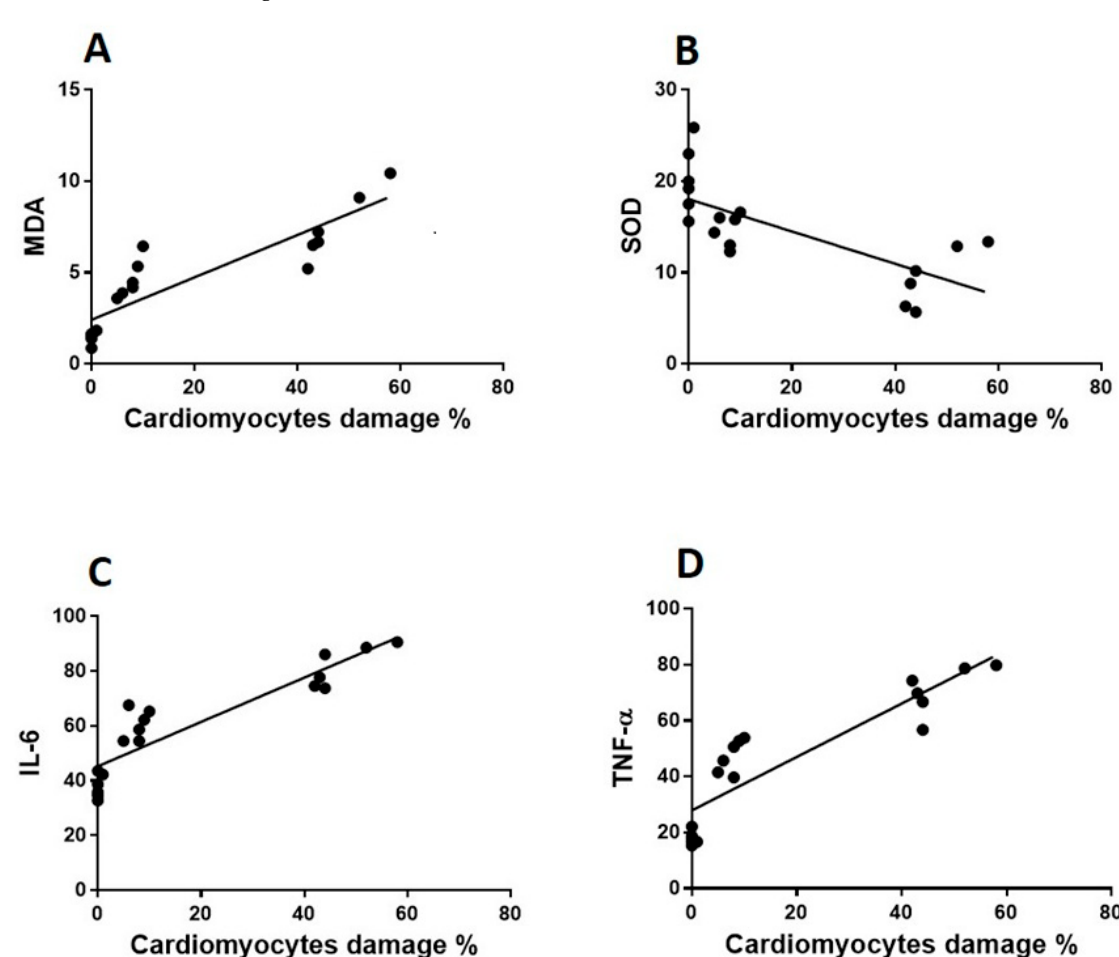
Figure 7. Correlation between cardiomyocytes and oxidative stress and inflammatory biomarkers. MDA, SOD, IL-6 and TNF- α levels of cardiac homogenate were estimated in all rat groups. The correlation between the percentage of cardiomyocyte damage and oxidative stress biomarkers (MDA and SOD) are shown in ( A , B ), respectively. The correlation between the percentage of cardiomyocyte damage and proinflammatory cytokines (TNF- α and IL-6) have been reported in ( C , D ) respectively.